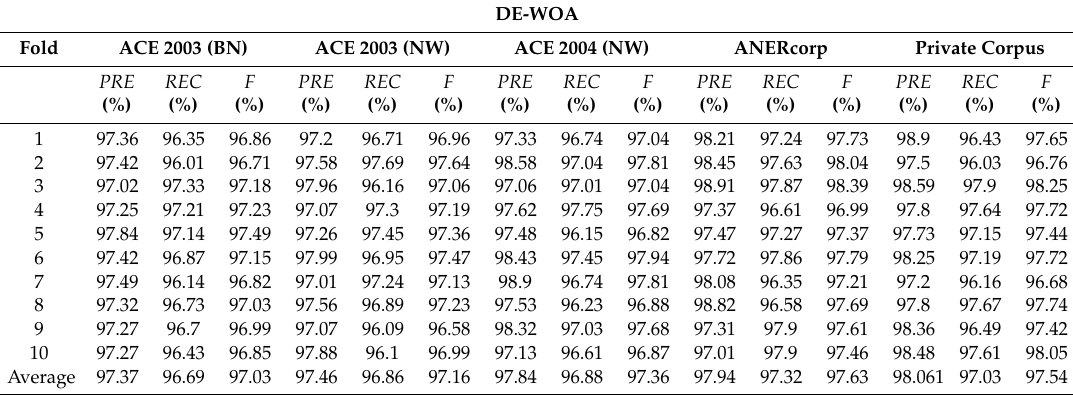
Table A5. Performance evaluation of ontology learning using the MFO over the five corpora.